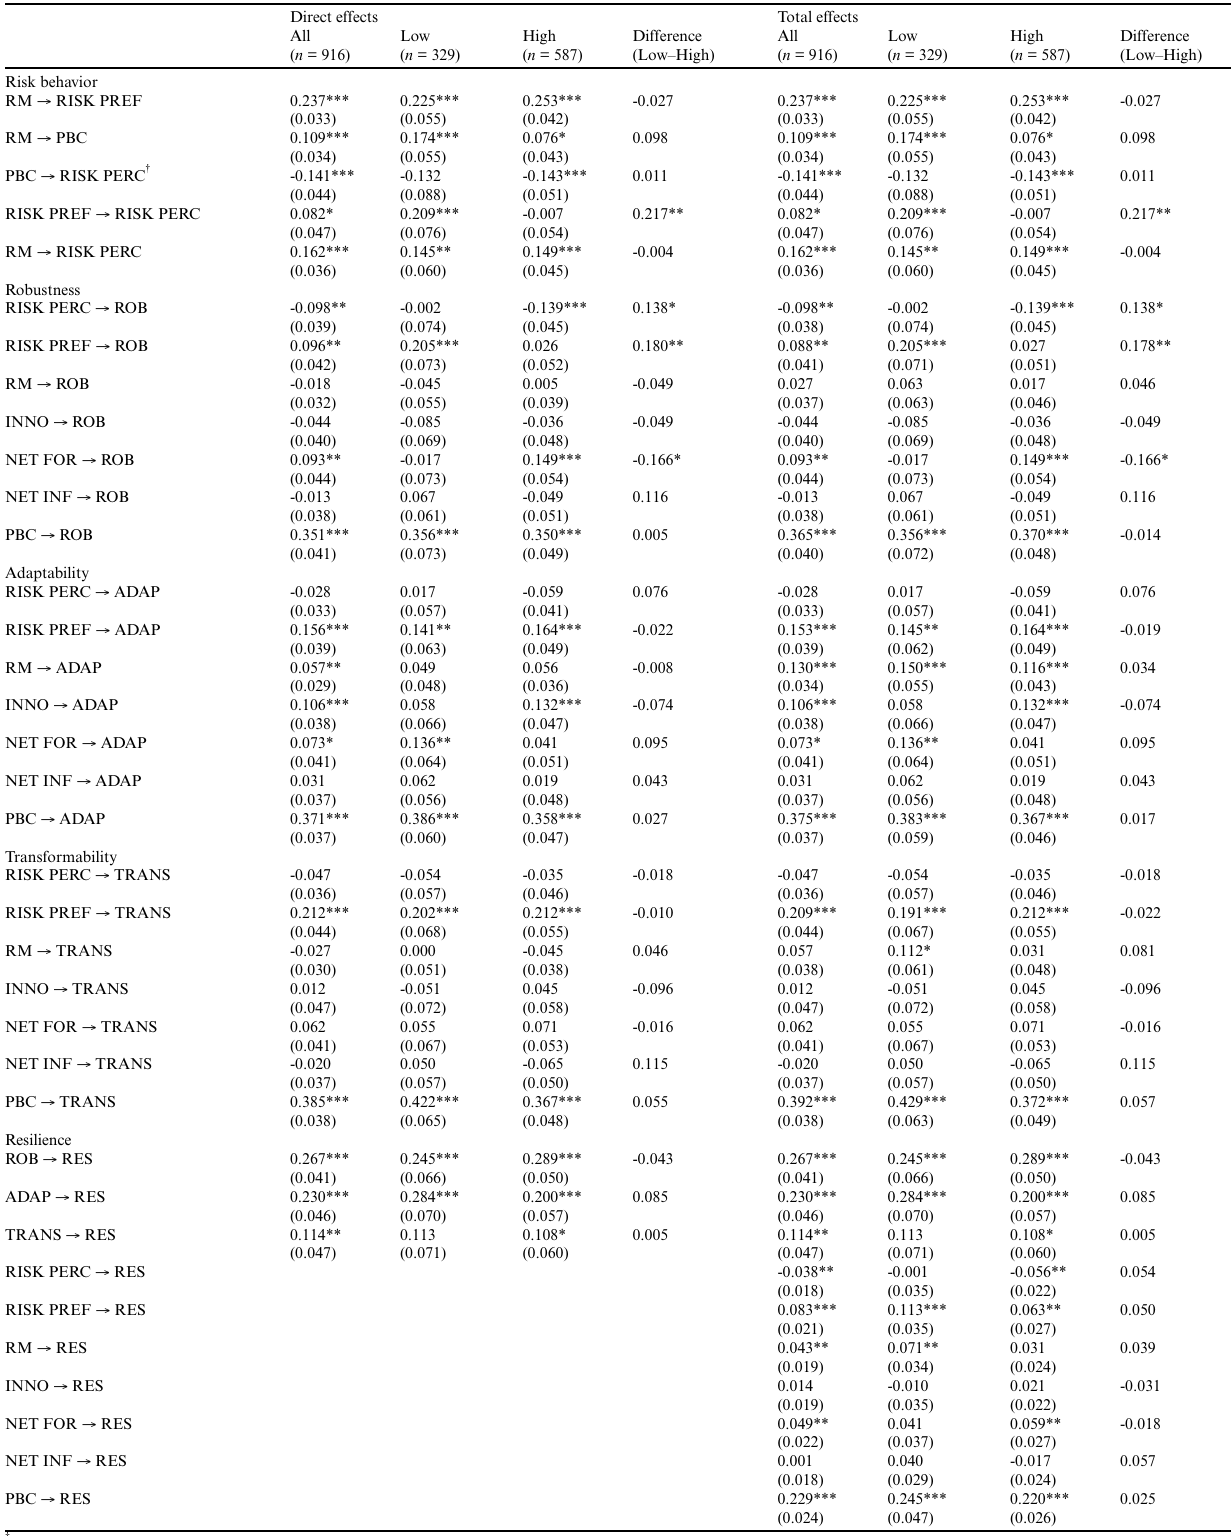
Table 4 . Path coefficients of the PLS-SEM. Direct and total effects are